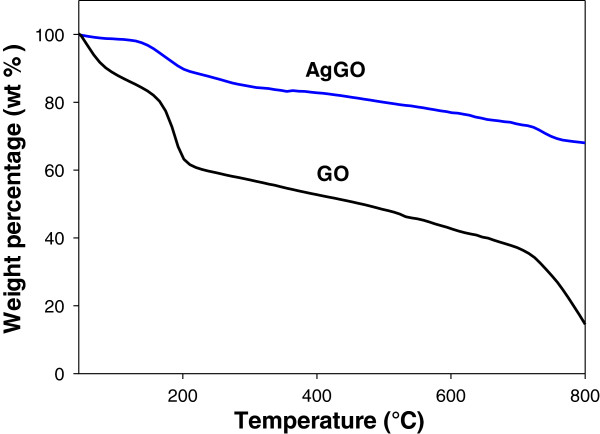
TGA of GO and AgGO.